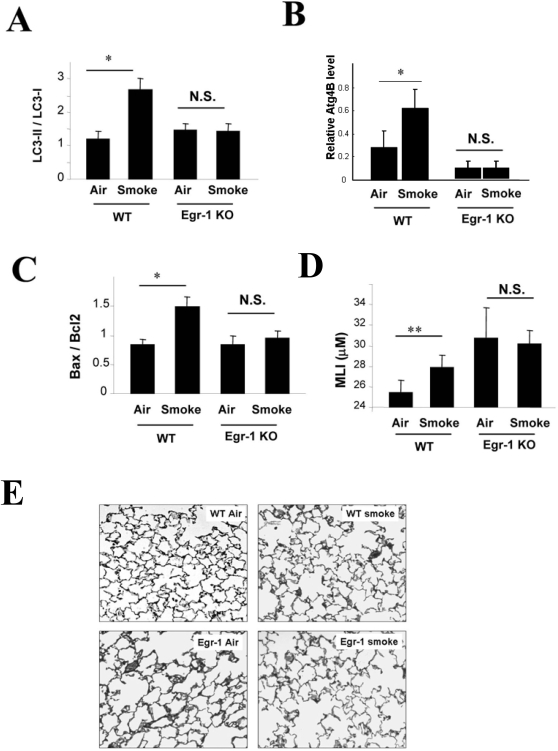
Role of Egr-1 in the regulation of autophagy, apoptosis, and emphysema in vivo during chronic cigarette smoke exposure.(A–C) Wild type C57BL/6 or Egr-1
−/− mice were exposed to chronic cigarette smoke exposure for 6 months (each group n = 5). Lung tissue homogenates were analyzed for (A) expression of LC3, (B) expression of Atg4B, (C) Bax/Bcl2 ratio. Lung tissue was evaluated for emphysema/airspace enlargement and mean linear intercept (D) and H+E staining (E).